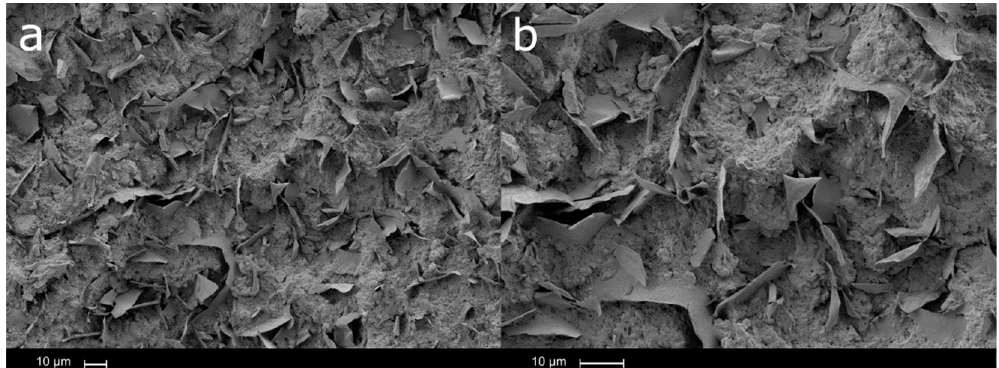
Figure 15. SEM micrograph of Solanyl ® C1201: ( a ) ×500 and ( b ) ×1000.